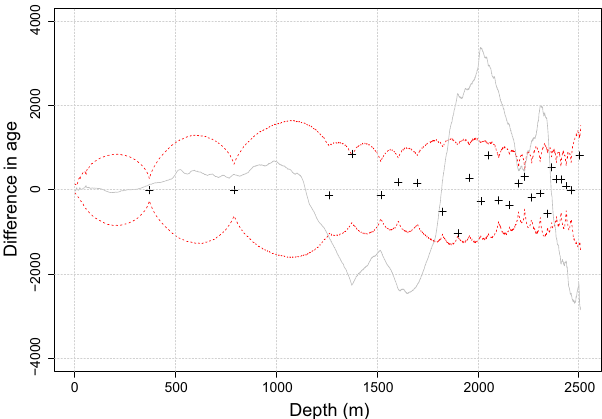
Figure 5. Difference of the 10th and 90th percentiles of the poste- rior distribution from the median of the posterior (red dotted lines), difference of each tie point from the median of the posterior (black crosses), and difference of the estimate by Parrenin et al. (2007) from the median of the posterior obtained in this study (grey